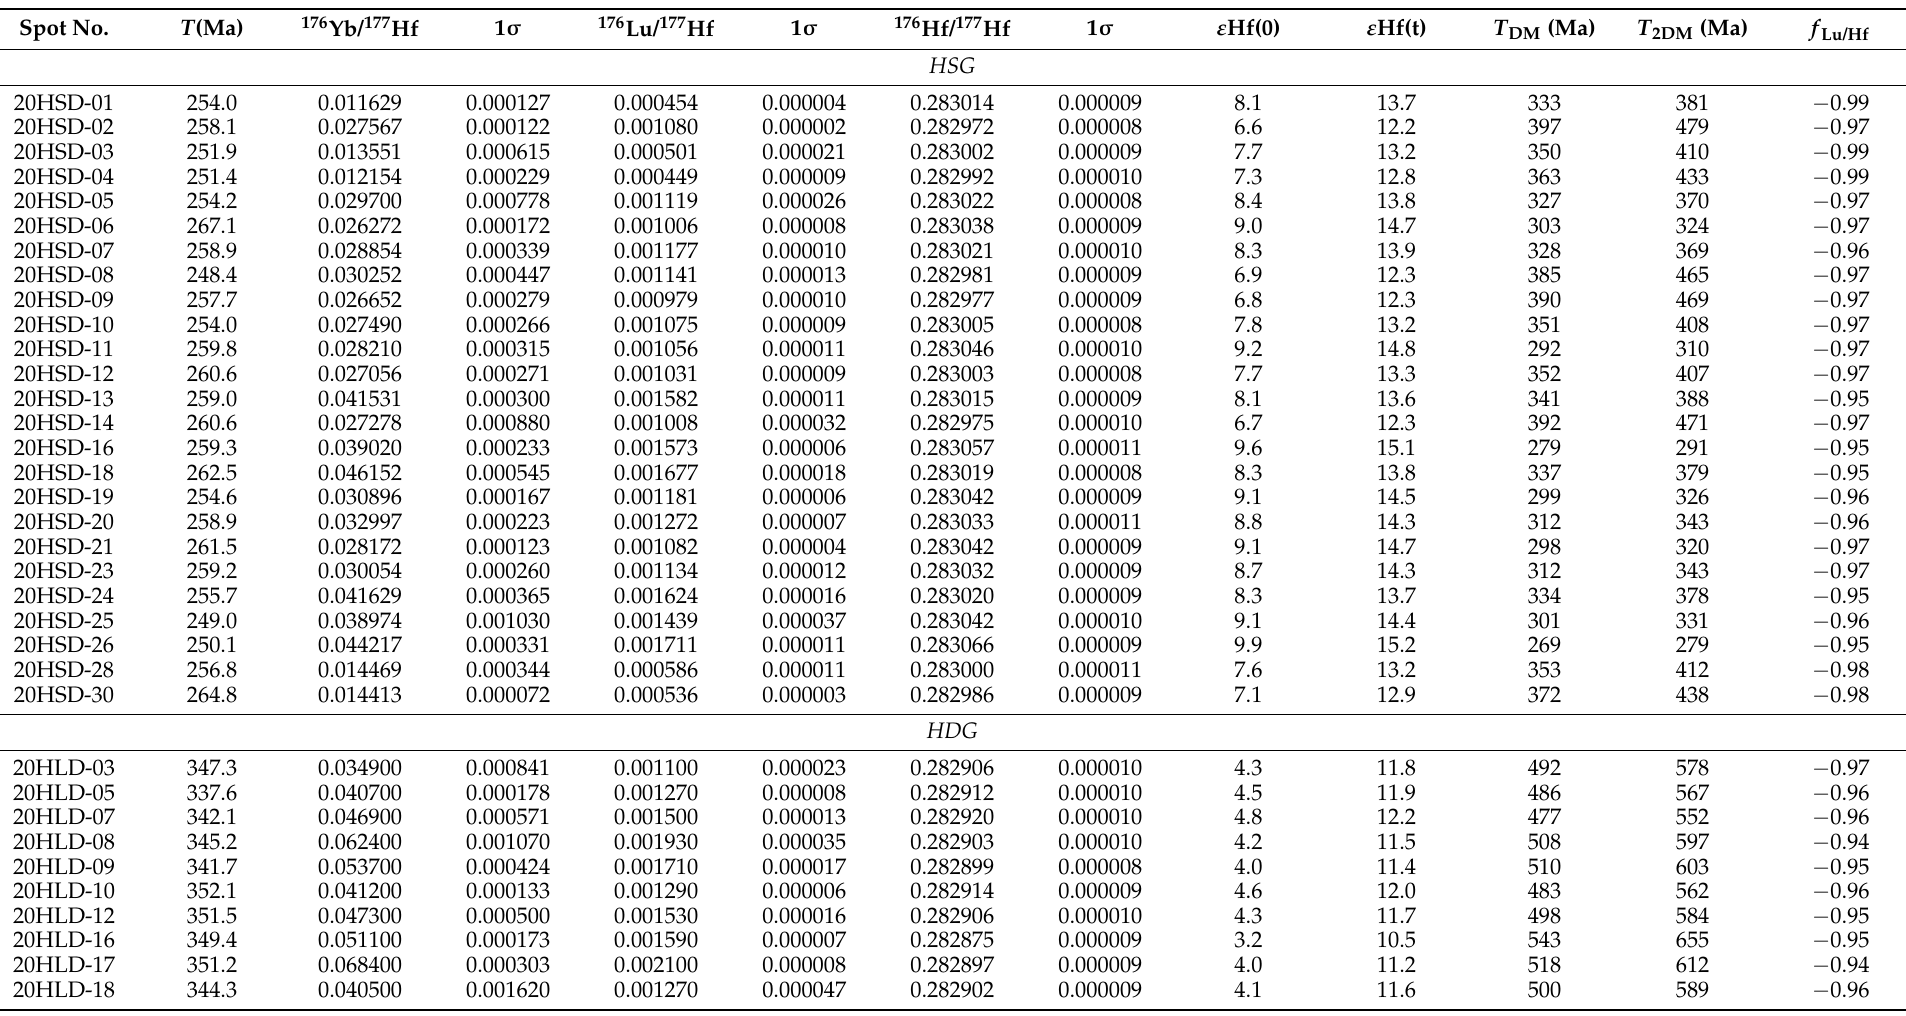
Table 6. Hf isotope composition of zircon grains from HSG and HDG of the KDSZ. Spot